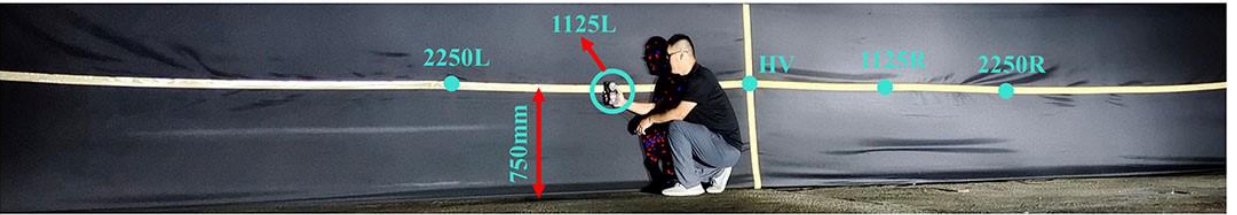
Figure 6. Isoilluminance diagram of the light source. It can be seen from Figure 6 that the isoilluminance diagram of the high-beam head- light is approximately symmetrical on the left and right axes, and the illuminance values of the light source decrease sequentially from the center to the margins. The isoillumi- nance diagram is an inherent characteristic of the light source. The illuminance values and spatial distributions that cause the driver to experience different levels of glare need to be obtained through the glare effect test. To this end, we assumed that the spatial distribution of different glare perceptions for the tested drivers was similar to the isoilluminance dia- gram of the high-beam headlight, and took the right half for research. The longitudinal distances between the glare source and the tested driver were 3 m, 5 m, 7 m, 10 m, and 12 m, due to the limitation of the laboratory size. 3.3. Tested Drivers According to the data published by The Ministry of Public Security of the People ’ s Republic of China, drivers aged 26 – 50 accounted for 70.71% of the total number of drivers by 2021. Therefore, in order to protect most drivers from the glare interference caused by the glare from headlights, our test took drivers aged 26 – 50 as participants. To avoid dif- ferential effects on the test results due to the gender, age, and personality of the tested drivers, 24 healthy drivers (mean = 36.8 years; standard deviation = 7.9 years) were ran- domly recruited. The subjects’ naked or corrected visual acuit y had to be 4.9 or higher, and they had to be free of color blindness, weakness, or other eye diseases; they were banned from using alcohol or drugs during the glare effect tests. 3.4. Procedure